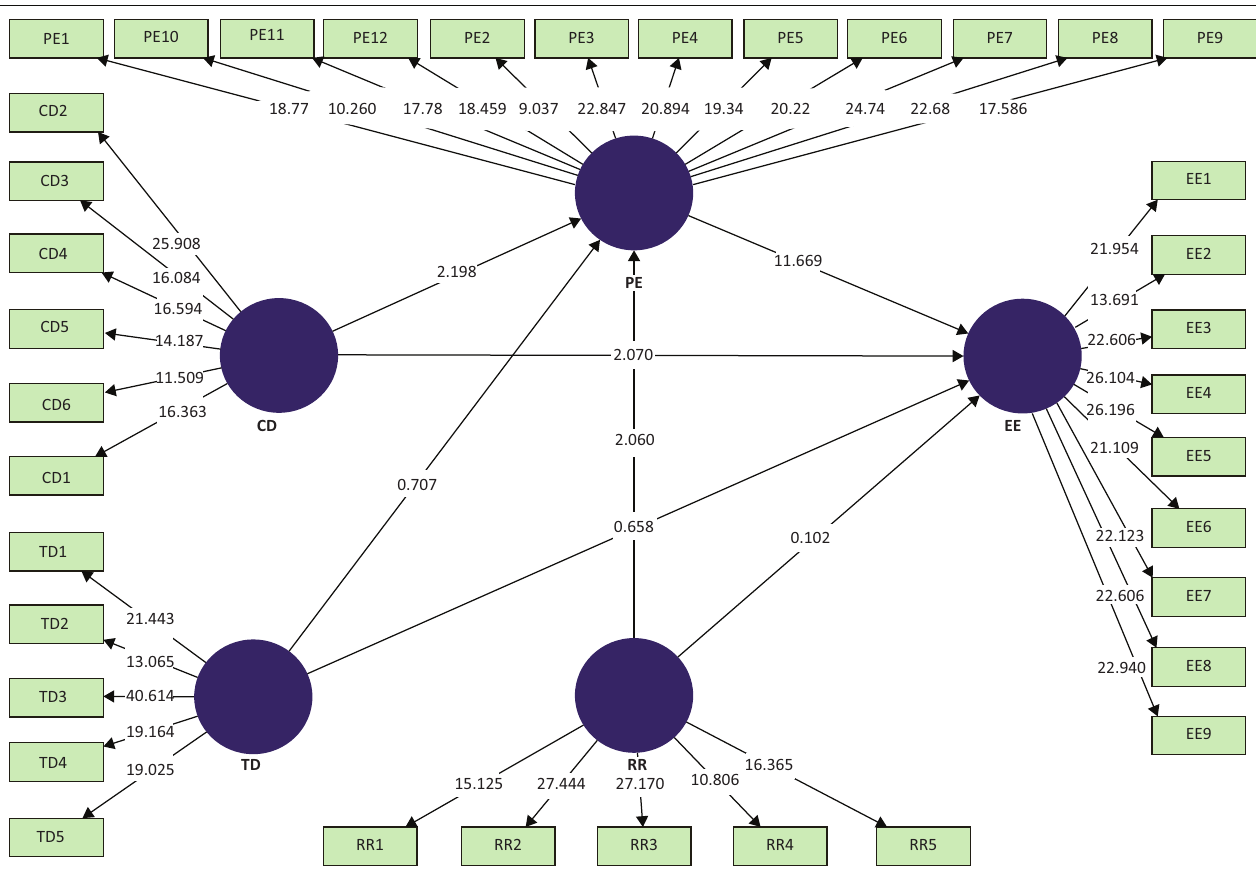
FIGURE 3: Structural model from PLS-SEM analysis.